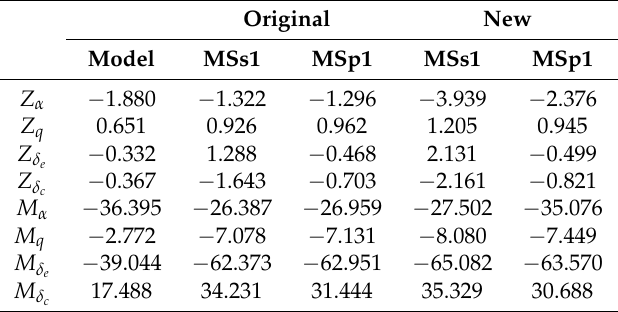
Table 4. Comparison of the estimates for the crest factor optimized multisine (MS) input signal run separately and in parallel. The model (17) is given as a reference.